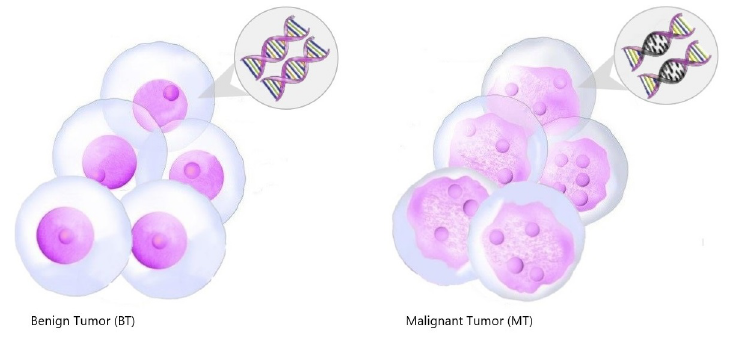
Figure 2. Illustration of kidney tumor